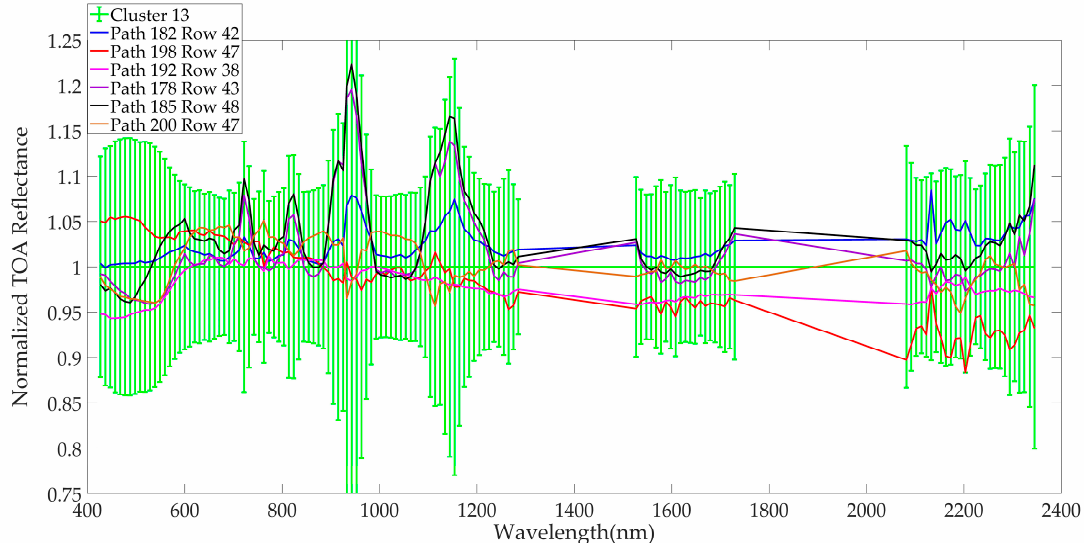
Figure 17. Validation of hyperspectral spectrum of Cluster 13.